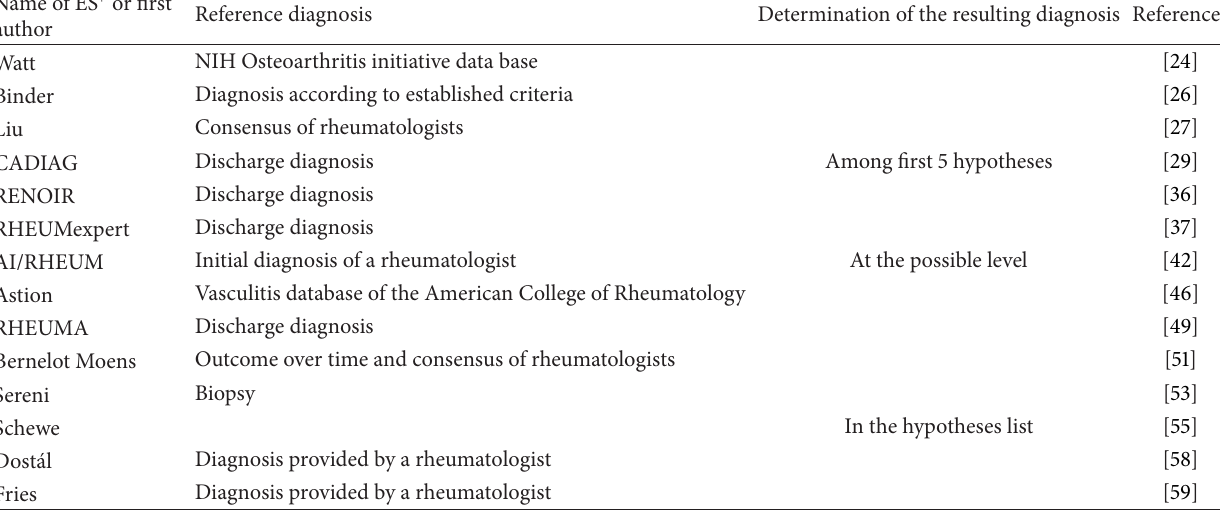
Table 3: Reference diagnoses and the determinations of the resulting